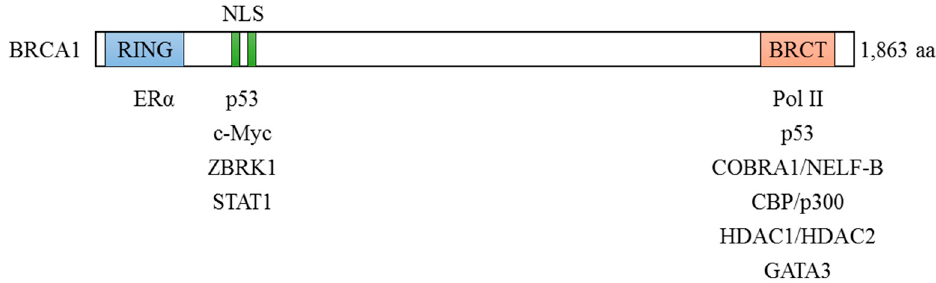
Figure 2. Interactions between BRCA1 and transcription factors.